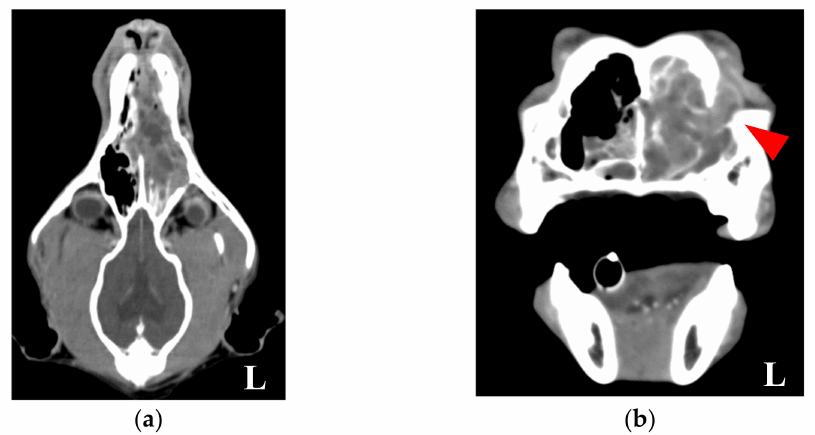
Figure 1. A contrast computed tomography image of the head. ( a ) Horizontal image. ( b ) Transverse image. A large, mild contrast-enhancing soft-tissue attenuating mass was present in the left nasal cavity. This mass extended caudally to the level of the cribriform plate. Partial lysis of the nasal septum was observed, and the left nasal mass invaded the right nasal cavity. Lysis of the lacrimal bone ( red arrowhead ) and mild invasion of the mass in the left orbit were observed. L: left.